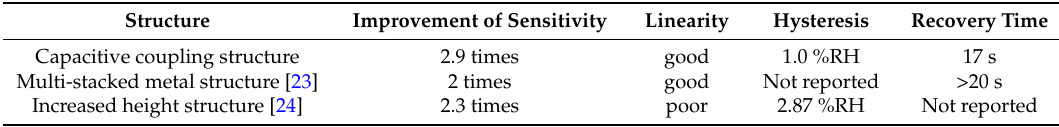
Table 2. Comparison of different optimized structures.